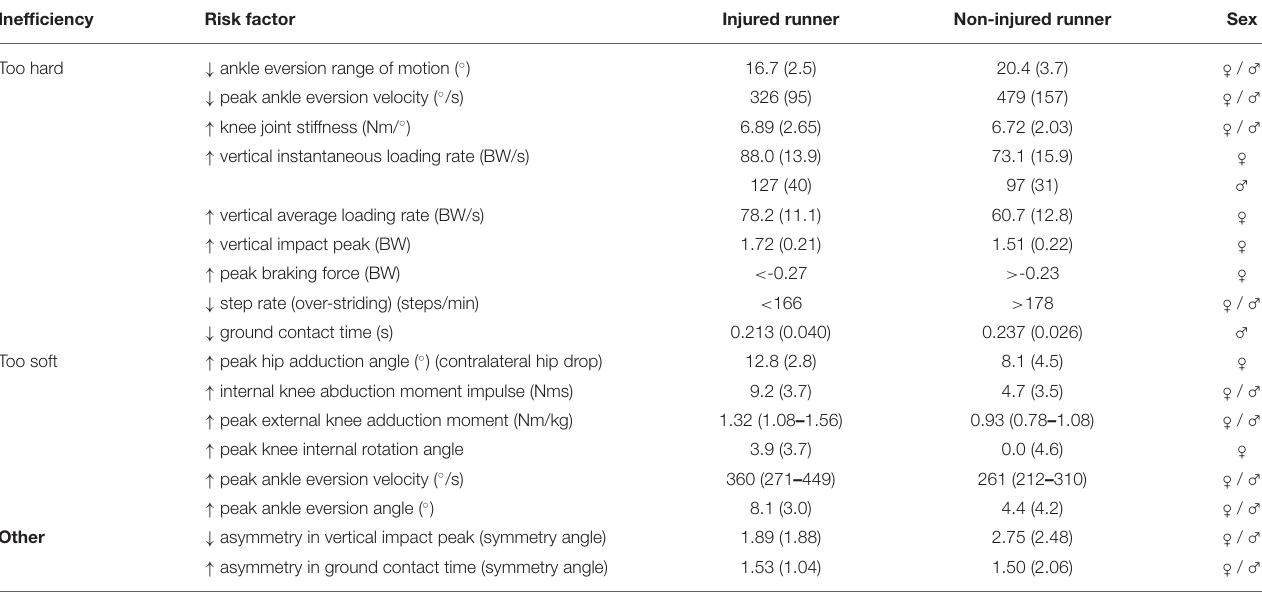
TABLE 1 | Kinematic, kinetic, and spatiotemporal risk factors as determined by a systematic review by Ceyssens et al. (2) and categorized according to the inefficiency identified by the PIMP approach.